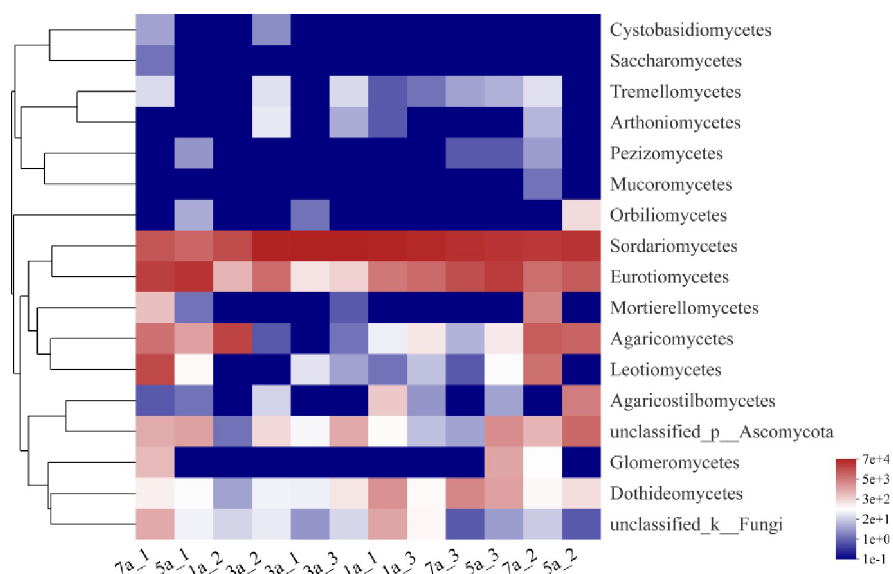
Fig 3. Class-level fungal communities heatmap of S . psammophila sand barriers under different setting years. The abscissa is the sample name, and the ordinate is the species name. The right side of the figure is the value represented by the color gradient, and the left side of the figure is the clustering tree of the species.